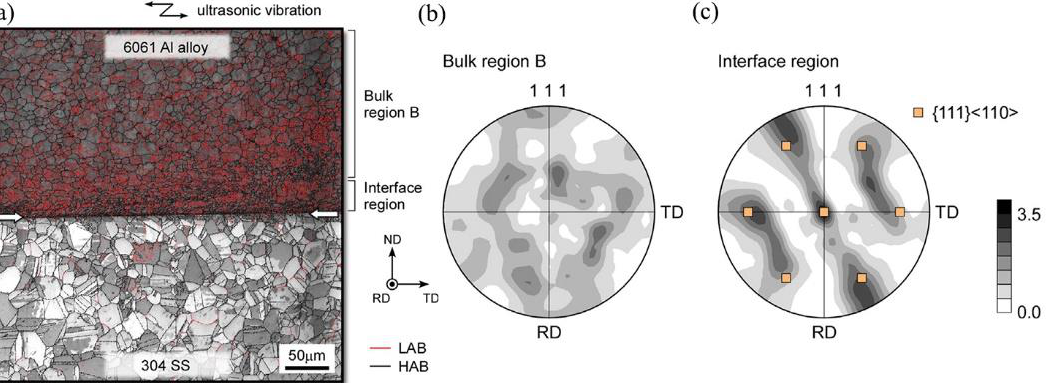
Figure 16. EBSD results at the welding interface between 6061 aluminum alloy and 304 stainless steel [45]: ( a ) grain boundary character distribution map; {111} pole figures extracted from ( b ) bulk region B and ( c ) interface region.